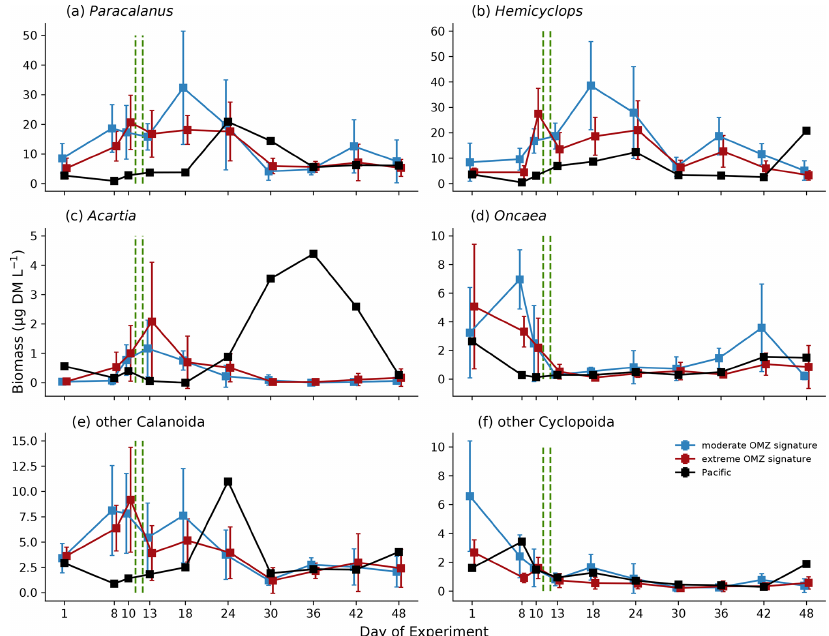
Figure 8. Biomass (µgDML − 1 ) development averaged for the moderate and extreme treatments of major taxonomic groups during the course of the experiment. Error bars depict 95% confidence intervals. The green vertical dashed lines indicate the days of OMZ water additions. The experimental phase 1 lasted from day 1 until day 11–12, phase 2 until day 40, and phase 3 until experiment termination. Note the different y -axis